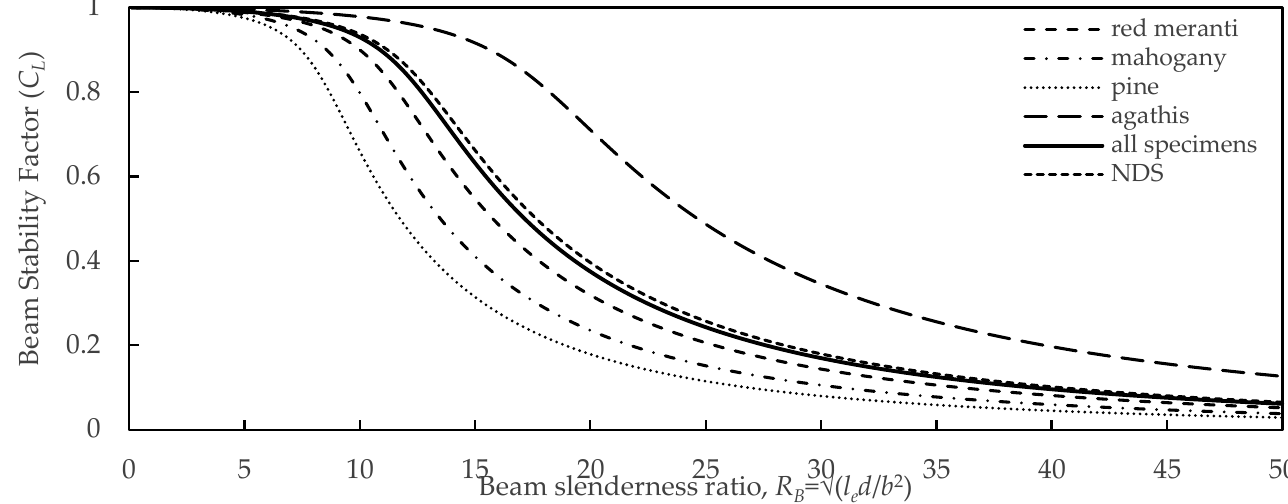
Figure 8. The experimental beam stability factor ( C L ) curve applicable to all slenderness ratios ( R B ) of each timber species and all specimens as compared to the NDS’s curve.